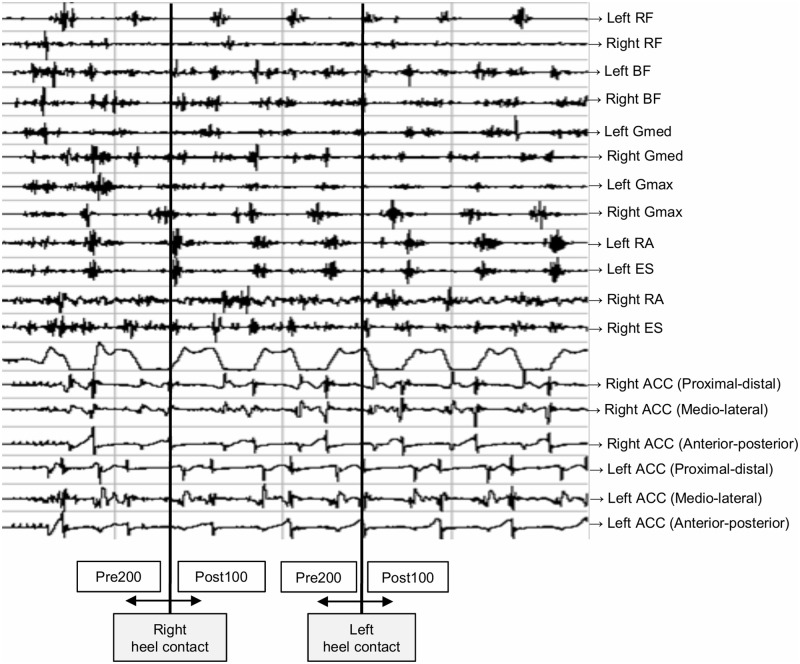
Visualized signals for each recorded muscle and the acceleration sensors in the electromyography analysis software during an unperturbed waling trial.Heel contacts provoked visible spikes, which assisted the data analyzer in detecting the heel contacts. Pre200: 200 to 0 ms before initial heel contact. Post100: 0 to 100 ms after initial heel contact. RF: rectus femoris, BF: biceps femoris, Gmed: gluteus medius, Gmax: gluteus maximus, RA: rectus abdominus, ES: erector spinae. ACC: the acceleration sensors.